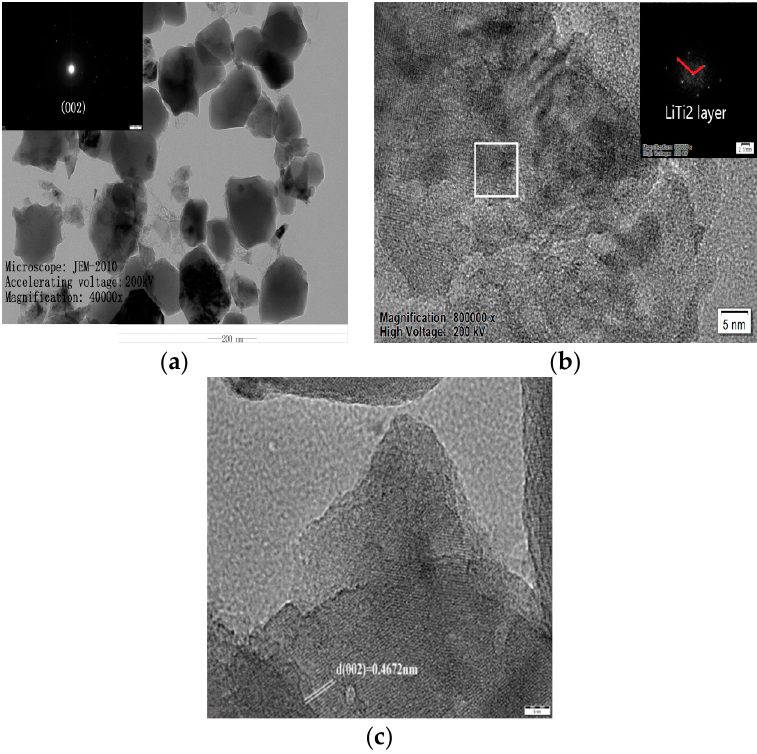
Figure 7. TEM images of samples after adding 1% Ni. ( a ) Sample Magnified 40,000×; ( b ) Selected area electron diffraction pattern; ( c ) (002) Crystal plane spacing.